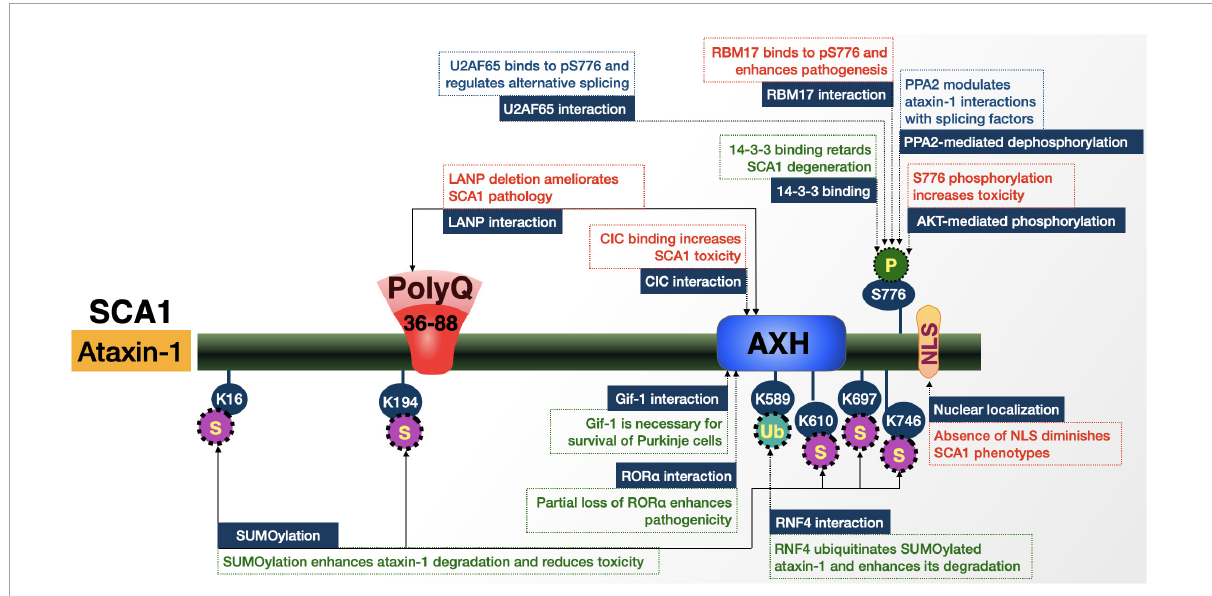
FIGURE5 Graphic representation of the SCA1 protein, its domains, interactions, and modifications. Details are in the main